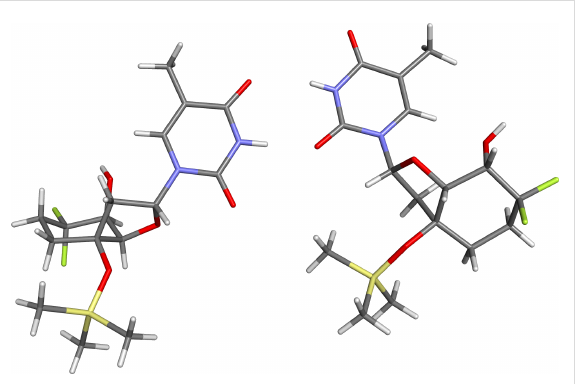
Figure 2: X-ray structure of nucleoside 6a (left) and 6b